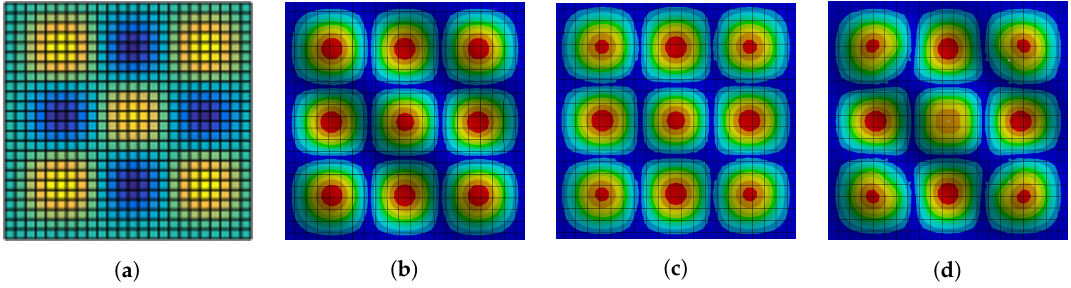
Figure 3. ( a ) Simulated mode (3,3) shape of a single panel. ( b ) Numerical model of the radiating panel’s mode (3,3) shape without couplings. ( c ) Numerical model of the radiating panel’s mode (3,3) shape with 5 inactive couplings. ( d ) Numerical model of the radiating panel’s mode (3,3) shape with five activated couplings.